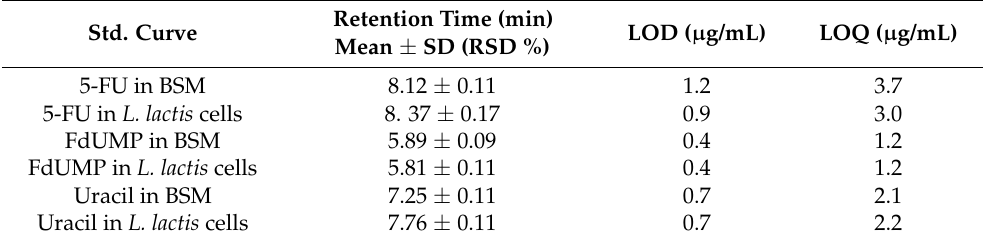
Table 2. LOD, LOQ, and RT values for 5-FU, uracil, and 5FdUMP. Values are provided for both the culture supernatant (BSM) and the bacterial precipitate ( L. lactis cells). Retention time values are means ± SD (n =